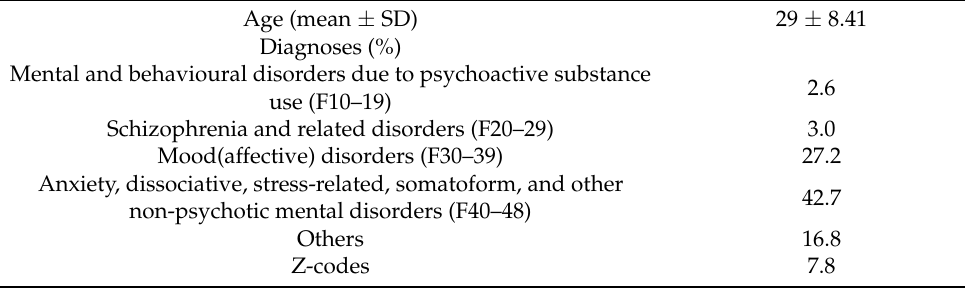
Table 1. Adults Patients’ characteristics and diagnoses ( n = 232). Age (mean ±